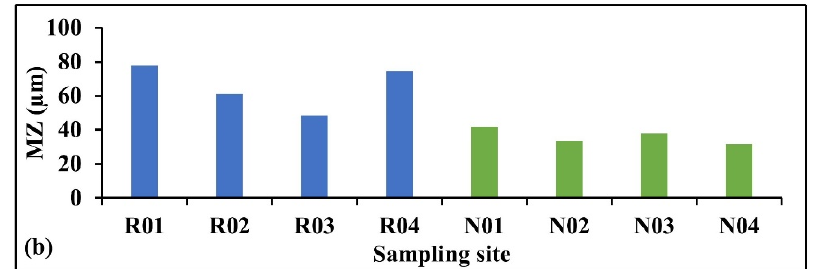
Figure 2. Representation of soil sample composition and the change in grain size with depth at each sampling site. ( a ) The change in grain size composition with depth; ( b ) the average mean grain size (MZ) of samples from each sampling site. R01–R04 = reclaimed sites; N01–N04 = natural coastal sites.